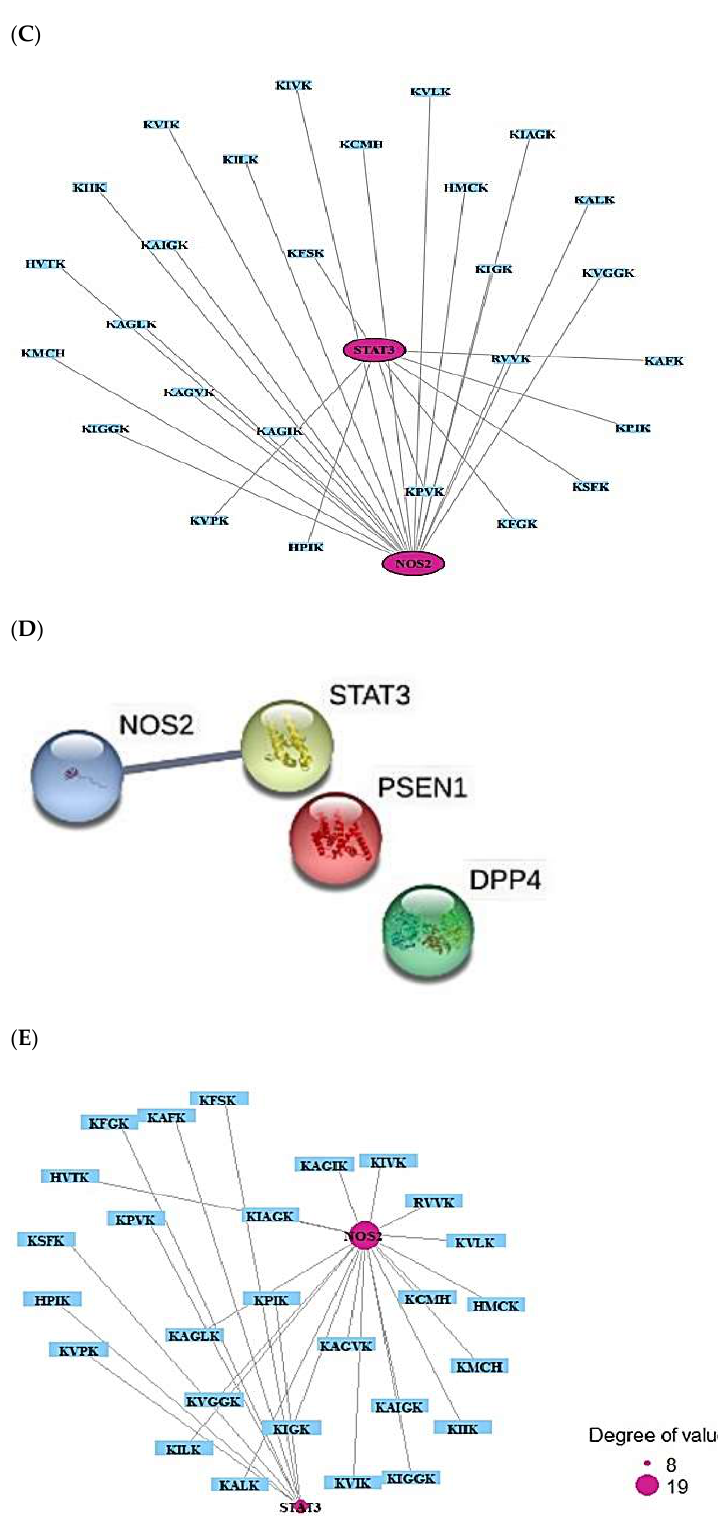
Figure 6. ( A ) Overlapping targets (four targets) between AMPs—AFPs’ axis (six targets) and cancer- related targets (4245 targets). ( B ) The number of one signaling pathway on AMPs—AFPs—ACPs’ axis. ( C ) Networks of HIF-1 signaling pathway on 29 nodes (27 peptides and 2 targets) and 27 edges. ( D ) Protein–protein networks of AMPs—AFPs—ACPs’ axis (four targets). ( E ) Size map of HIF-1 signaling pathway on NOS2 and STAT3 (29 nodes and 27